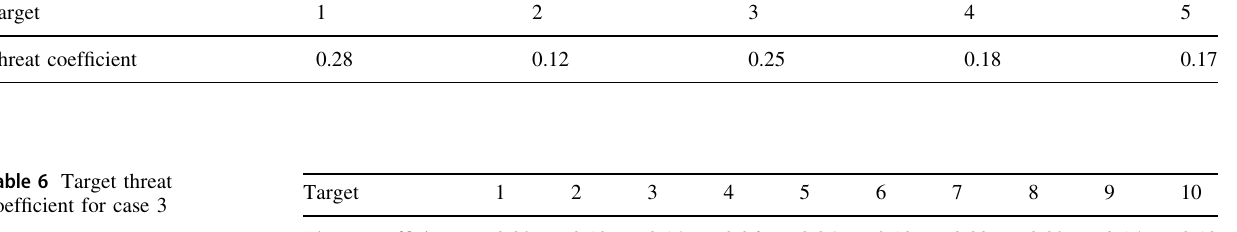
Table 5 Target threat coefficient for case 2 Target